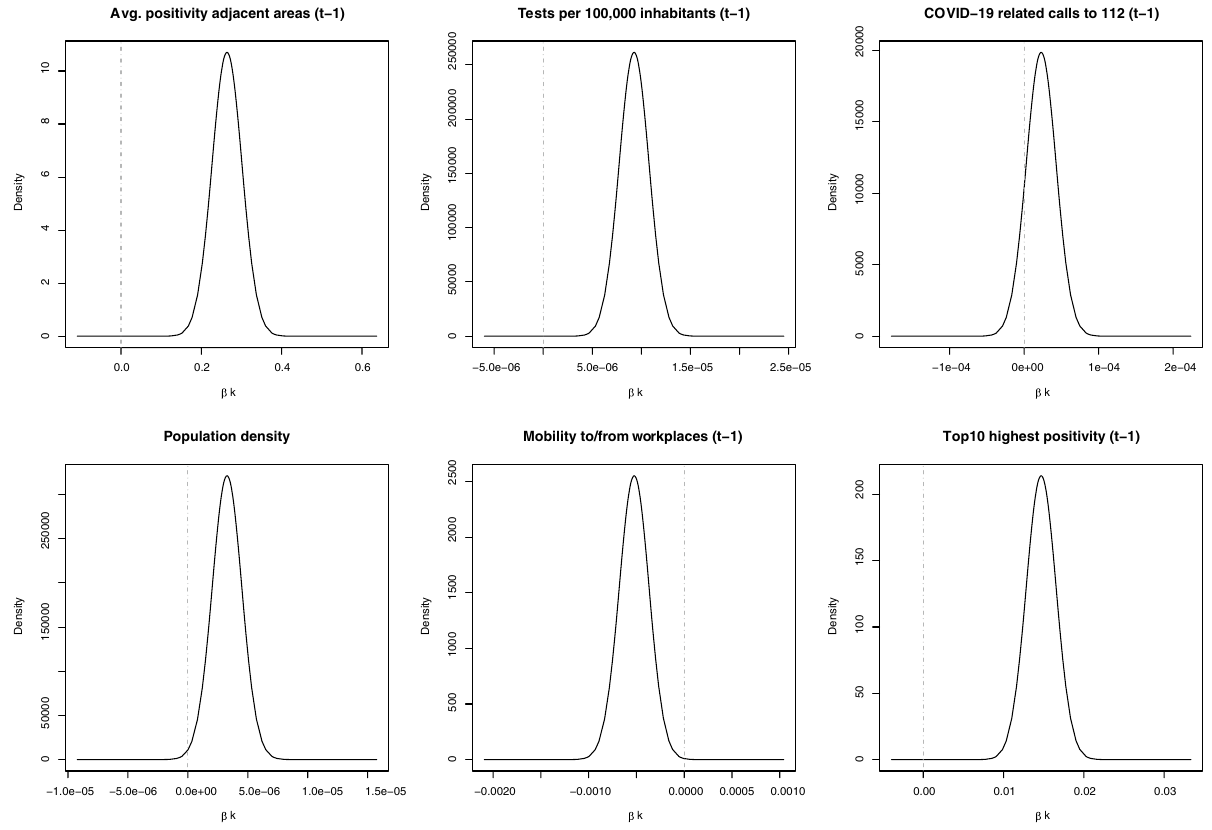
Figure 3. Posterior distributions for β k in prediction model for week 21, 2021. The gray dot-dashed lines indicate